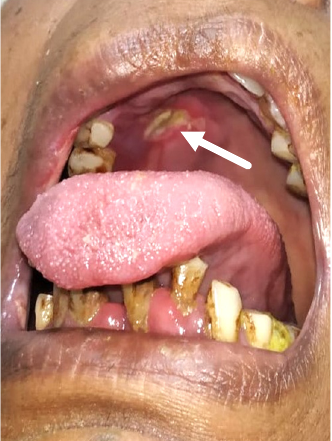
Figure 1. This is a clinical picture showing palatal eschar (white arrow).